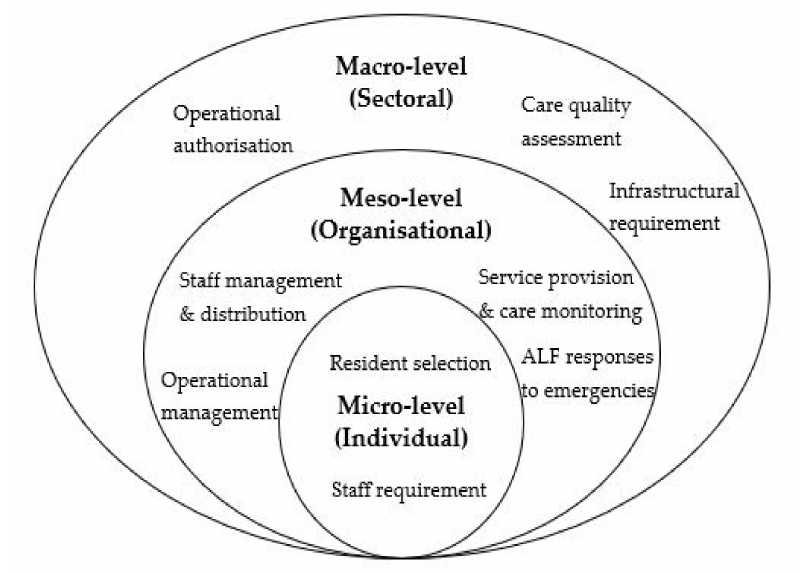
Figure 1. Governance framework for